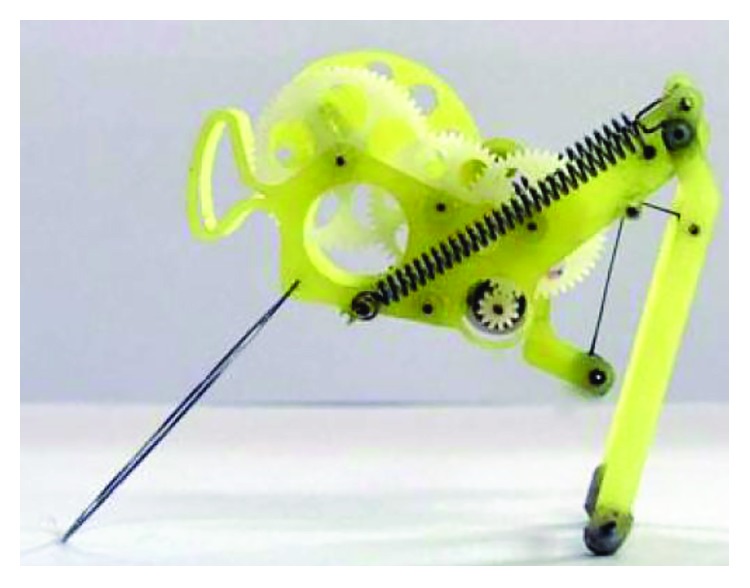
Locust-like jumping robot [44].